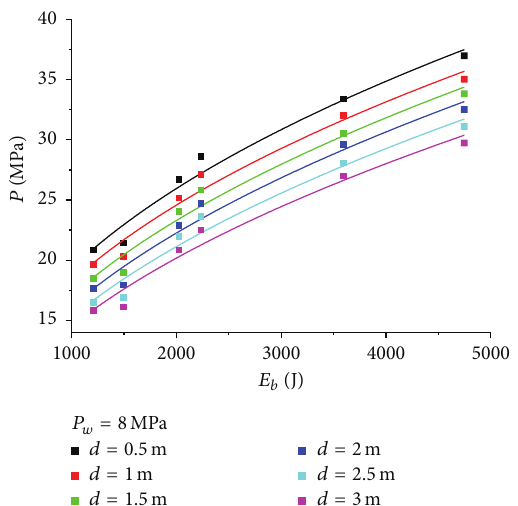
Figure 10: Relationship between breakdown energy ( 𝐸 𝑏 ) and shock-wave peak pressure for different transfer distances and hydrostatic pressures.